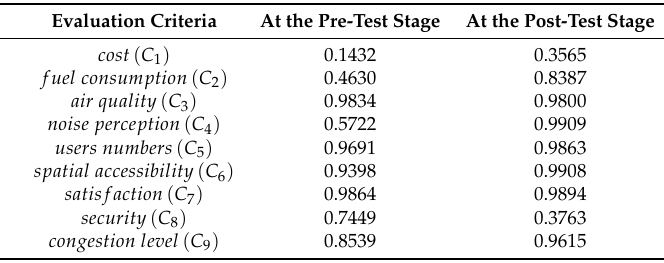
Table 7. Global utilities for nine